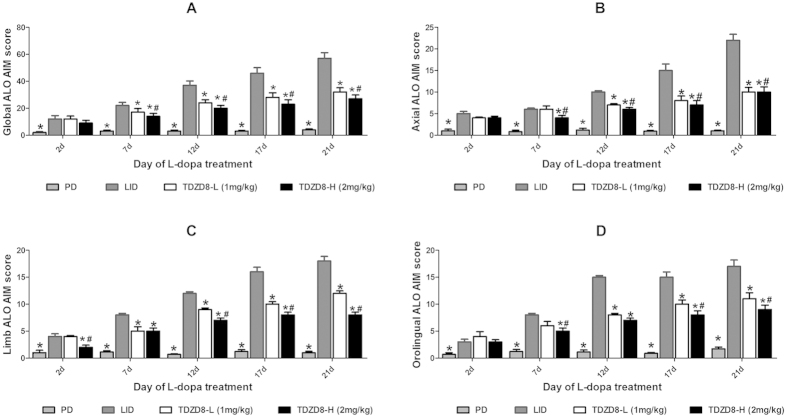
The effect of TDZD8 on the development of L-dopa-induced dyskinesia in 6-OHDA-lesioned rats.Chronic TDZD8 treatment significantly attenuates dyskinesia score for 3 weeks. For each day, a total AIM score was calculated as the sum of the basic score multiplied by the amplitude score for each AIM subtype, excluding the locomotive subtype. (A) time course of the sum of axial, limb, and orolingual (B) timecourse of the axial score, (C) time course of the limb score and (D) time course of the orolingual score on each testing session were rated following the administration of L-dopa and TDZD8. Data are presented as mean ± SD. *p < 0.05 vs LID group; #p < 0.05 vs TDZD8-L group (Kruskal Wallis followed by Dunn’s test for multiple comparisons or a Mann–Whitney U test).